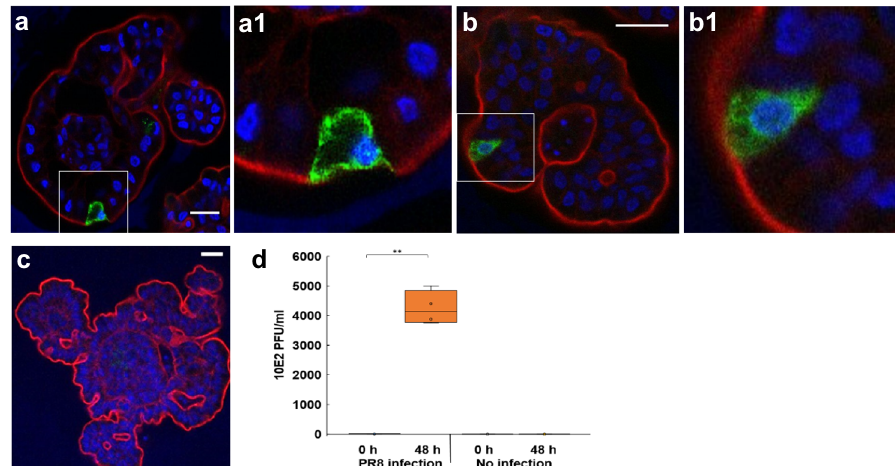
Fig. 9 Chicken enteroids as a model for host – viral interactions. a – b Representative z-axis projections of chicken enteroid 3 days in culture whole-mount stained to detect cell nuclei (DAPI, blue), F-actin-expressing brush border (red) and virus nucleoprotein (green) after incubation with in fl uenza A virus (PR8) for 48 h. a1 Magni fi ed image of a . b2 Magni fi ed image of b . c Isotype control. Images are representative of data from at least 3 independent cultures each, containing 2 – 3 embryos. Scale bar: 20 µ m. d Box and whisker plot represent viral titers, determined by plaque assay in supernatant from ~800 infected enteroids at 0 and 48 h post-wash. Data is derived from 4 independent experiments each containing 2 – 3 embryos and ~800 seeded enteroids/ well. ** p < 0.001, T = − 14.98, 95% CI for mean difference ( − 514720, 334344), df = 3 using a paired t -test